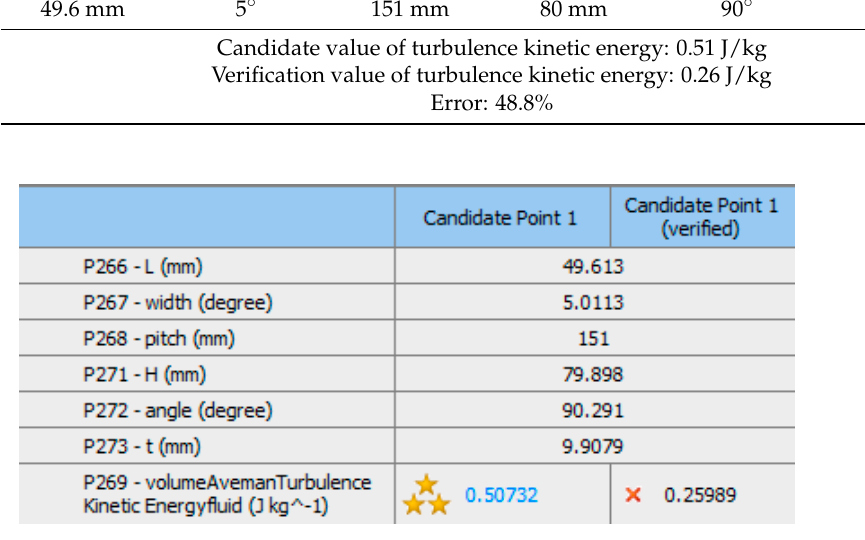
Table 5. The result obtained from response surface.